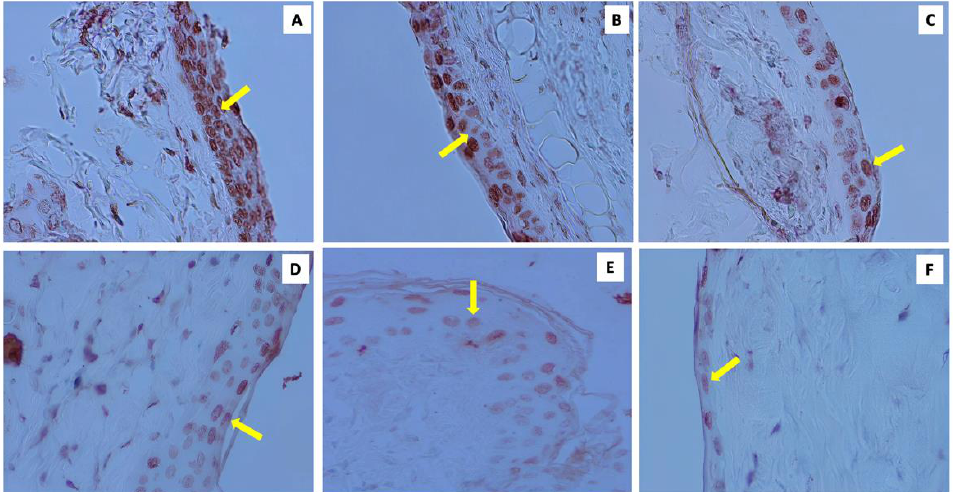
Figure 2. Apoptotic cells, indicated by brown staining in the nuclei (arrow), at 400x magnification under an Olympus Type CX-31 microscope, in the UVB-only group with majority apoptosis cells ( A ), acetone ( B ), 0.1 µM concentration ( C ), 1µM concentration ( D ), 10 µM concentration ( E ), and 100 µM concentration with the least amount of cell apoptosis ( F